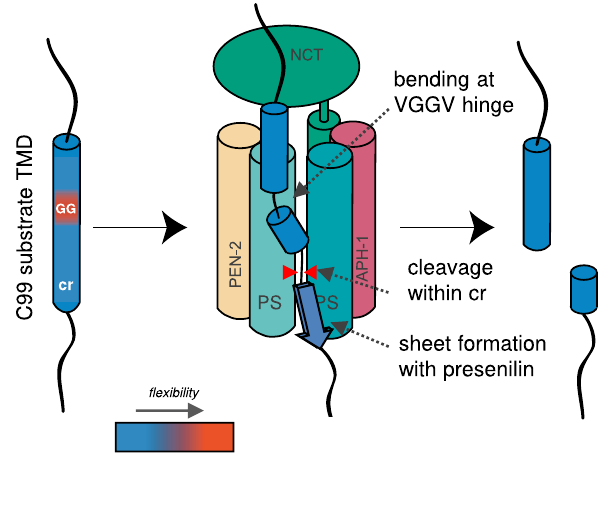
Fig. 7 Graphical summary of the structural features enabling cleavage of a TMD by γ